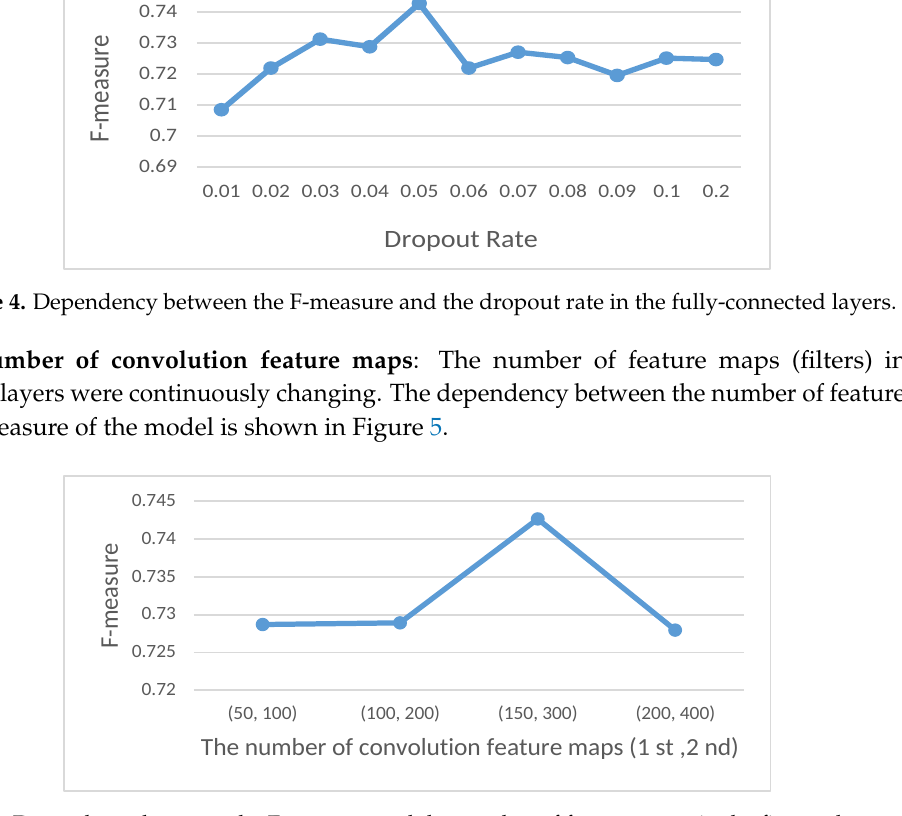
Figure 5. Dependency between the F-measure and the number of feature maps in the first and second convolution layers